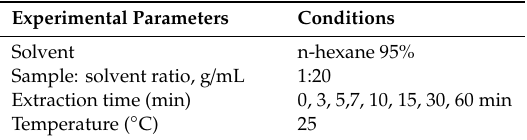
Table 3. Experimental parameters of solvent extraction.